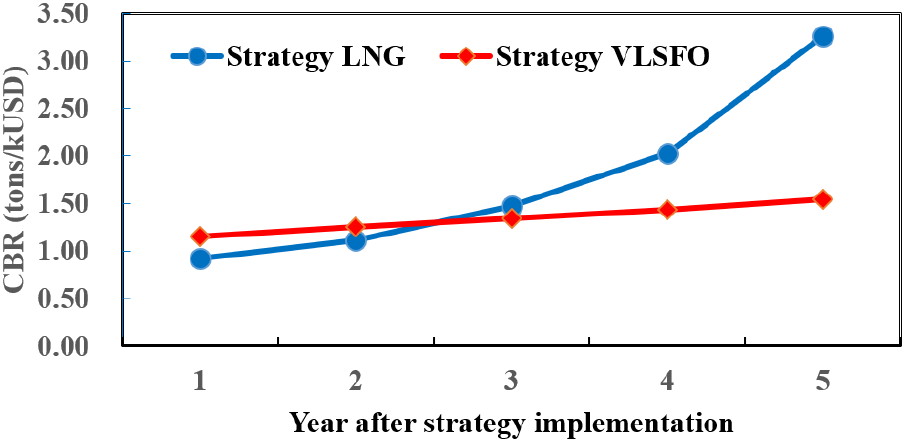
Figure 5. CBR analysis of the VLSFO and LNG Strategies.